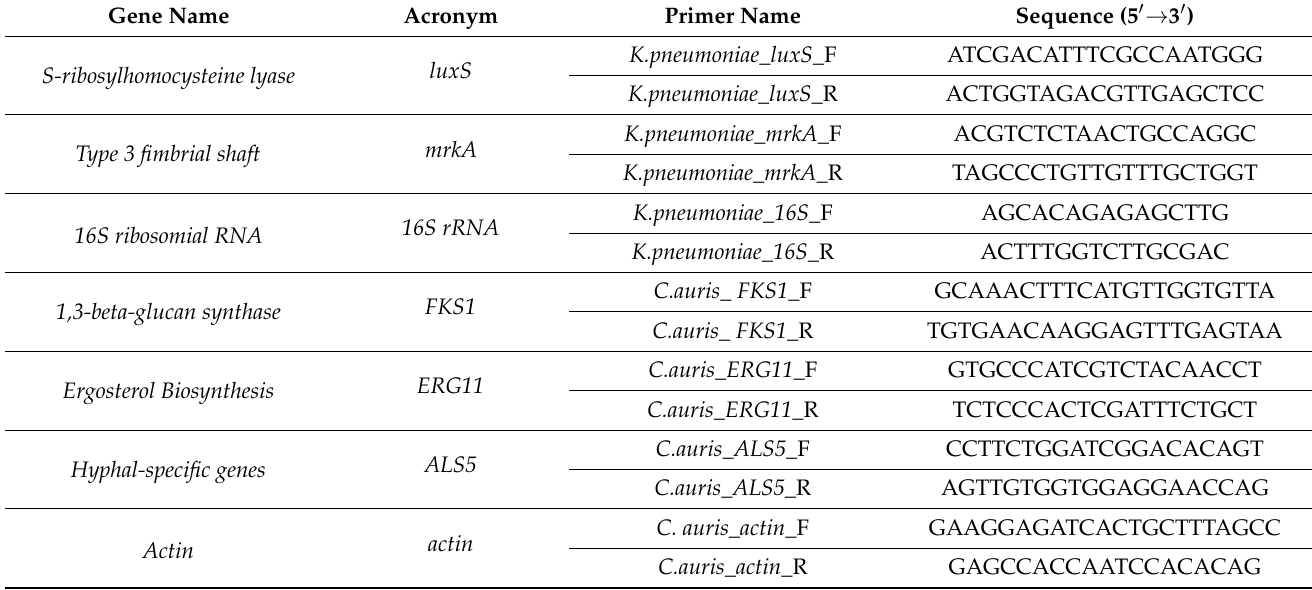
Table 1. Gene-specific primers used for real-time